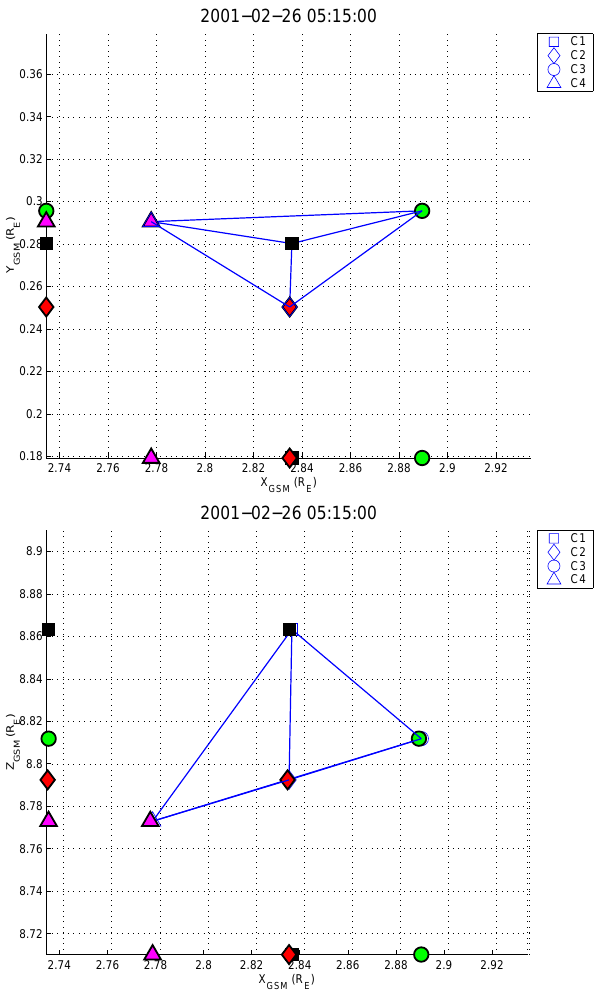
Fig. 5. The Cluster tetrahedron configuration around the time of the observations, with spacecraft positions in the ( a ) x–y plane and ( b ) x–z plane